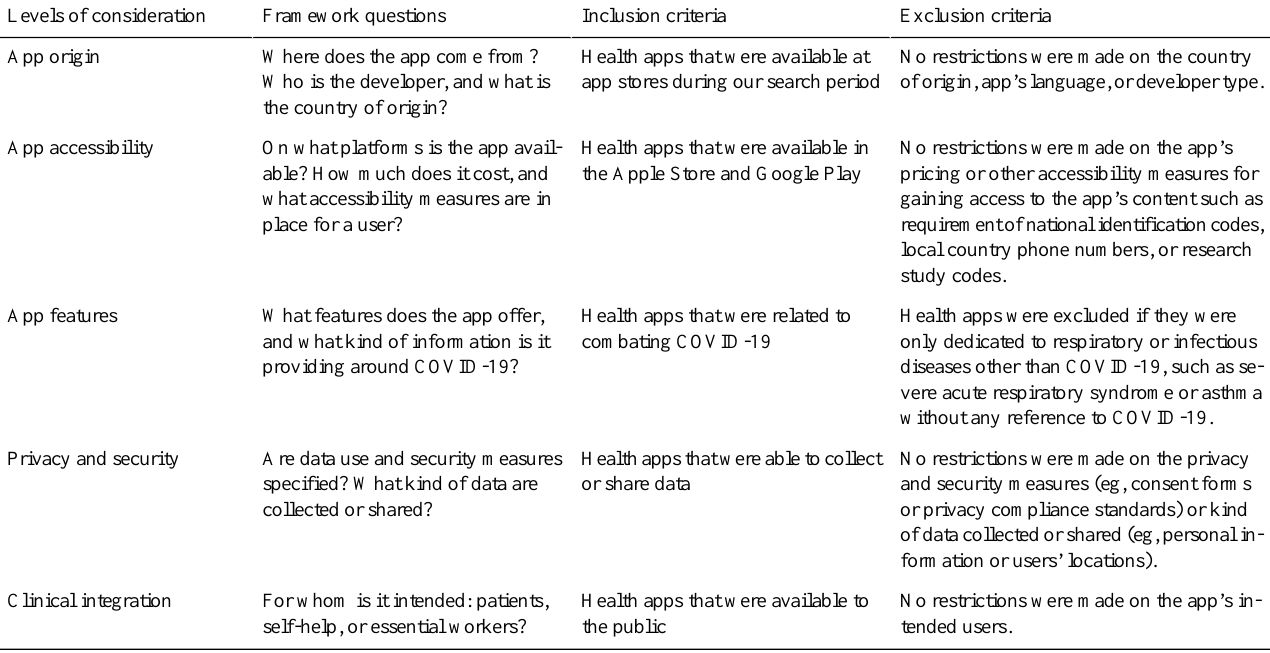
Table 1. The inclusion and exclusion criteria of apps are presented based on a framework developed by Ramakrishnan et al